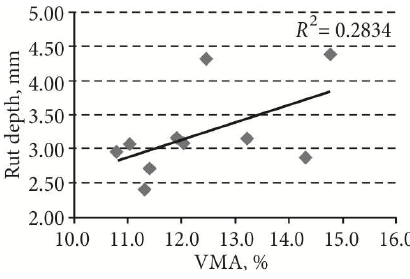
Fig. 5. The VMA versus rut